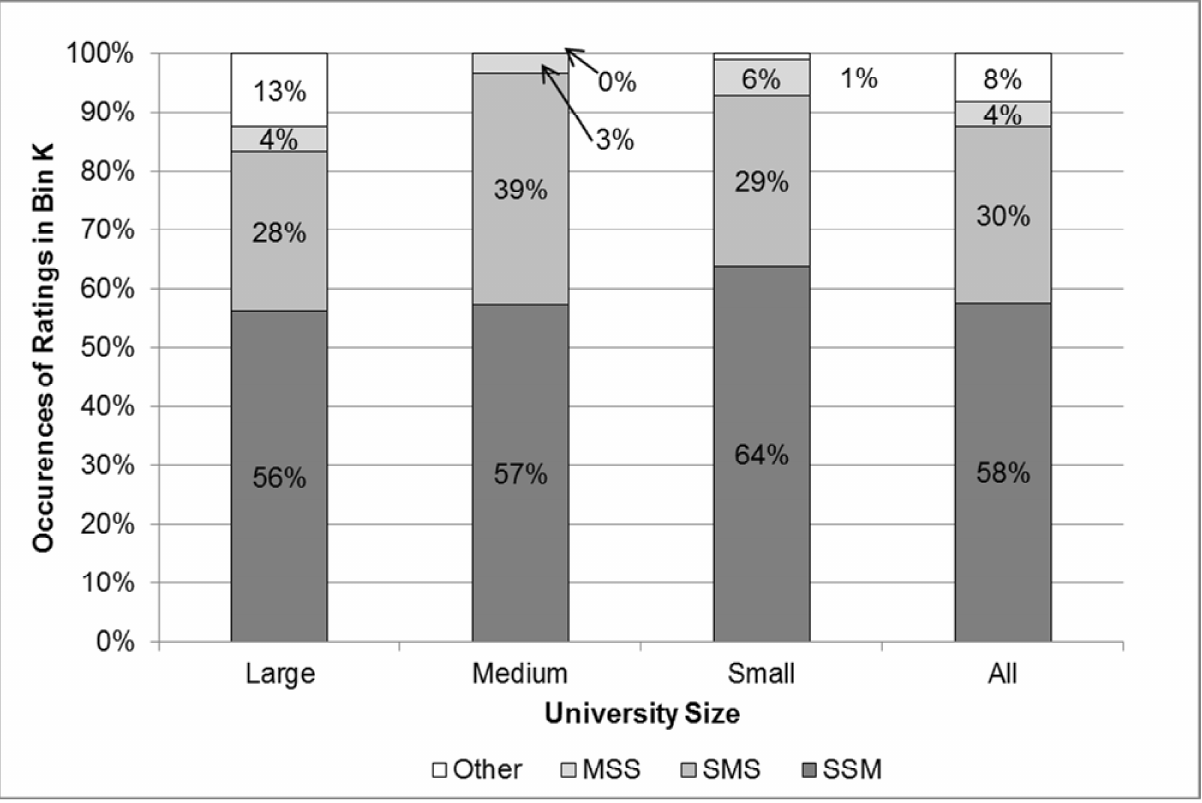
Figure 2 Percentage of Occurrences of Various Combinations of Ratings in Bin K by University Size for the 2020